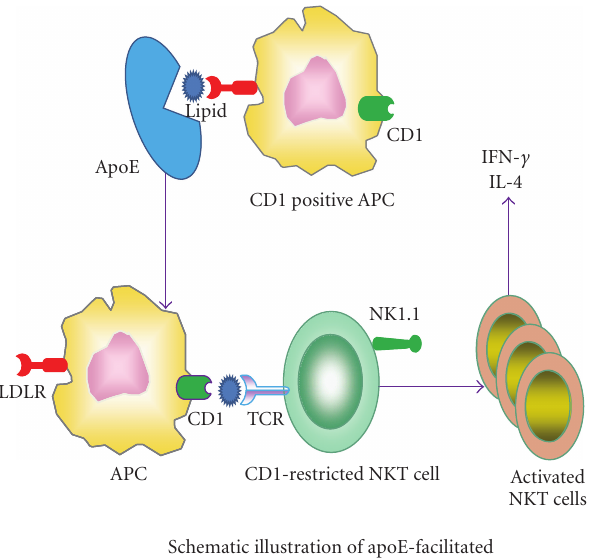
Figure 1: ApoE facilitates activation of CD1 restricted NKT